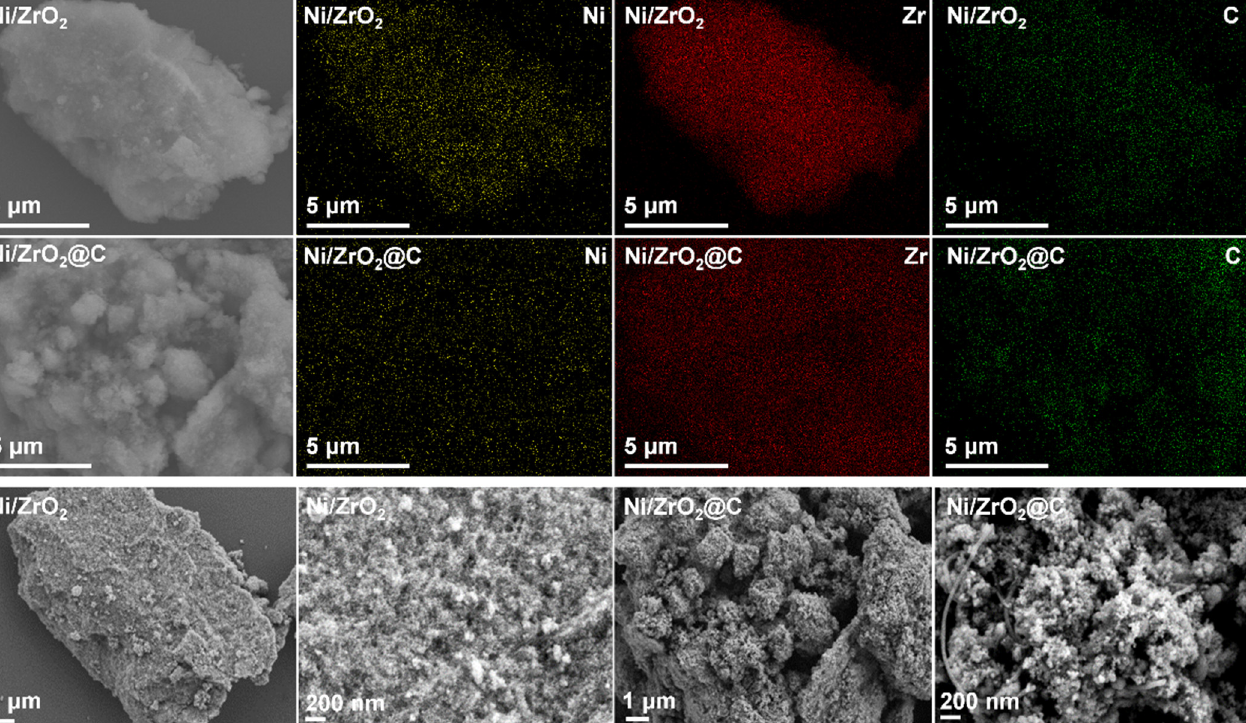
along the metallic nickel nanoparticles. This phenomenon is typically observed in